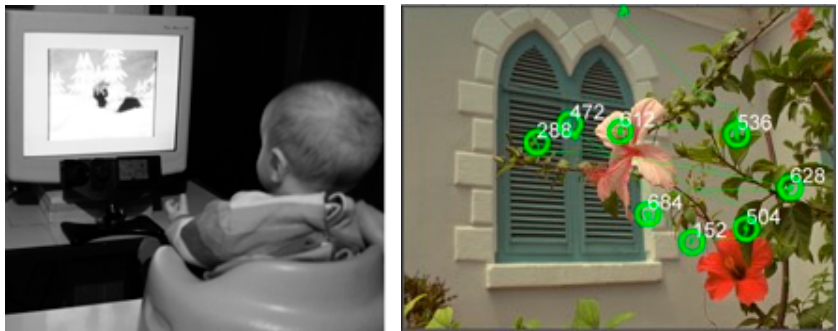
Figure 4. Evaluation of the eye-tracking protocol with a 6-month-old child; illustration of the setup and data in the spatial domain. Left: preparing for calibration. Right: scan path of the eye trajectory (numbers indicate fixation duration, in milliseconds).